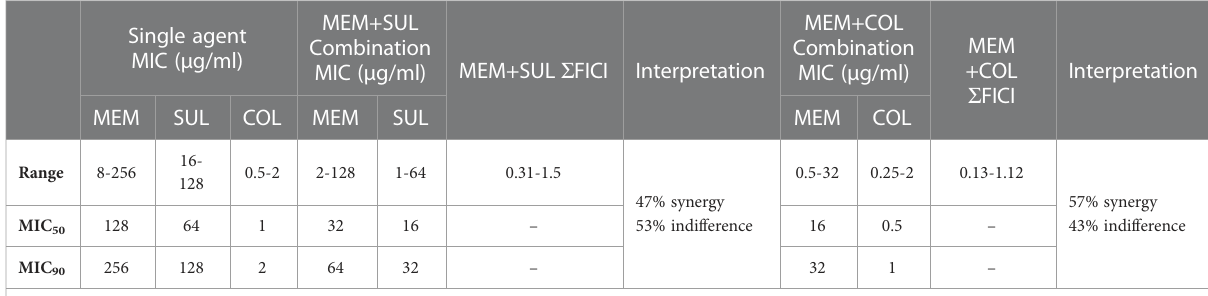
TABLE 4 Summarized results for drug combinations tested by checkerboard method against 100 CRAB